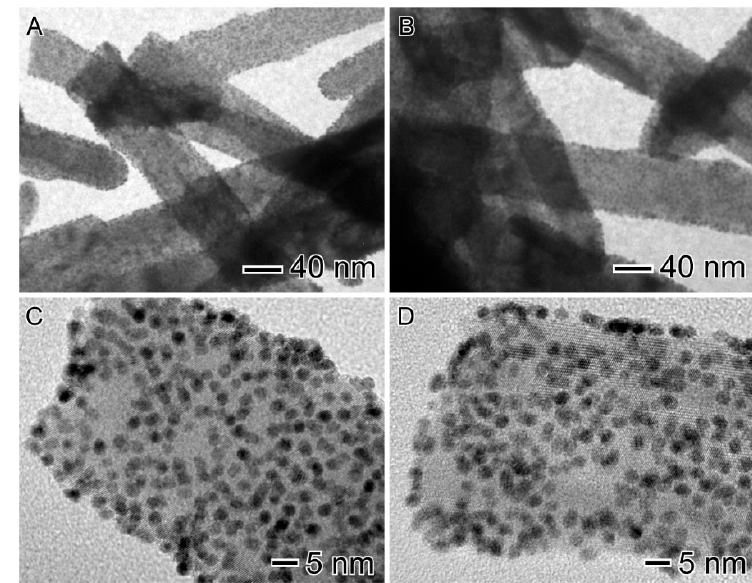
Figure 2. TEM ( A , B ) and HRTEM ( C , D ) images of TiO 2 nanowires decorated with ultrasmall Pd ( A and C ) and Pt ( B and D ) nanoparticles, covering the entire surface of the nanowires.